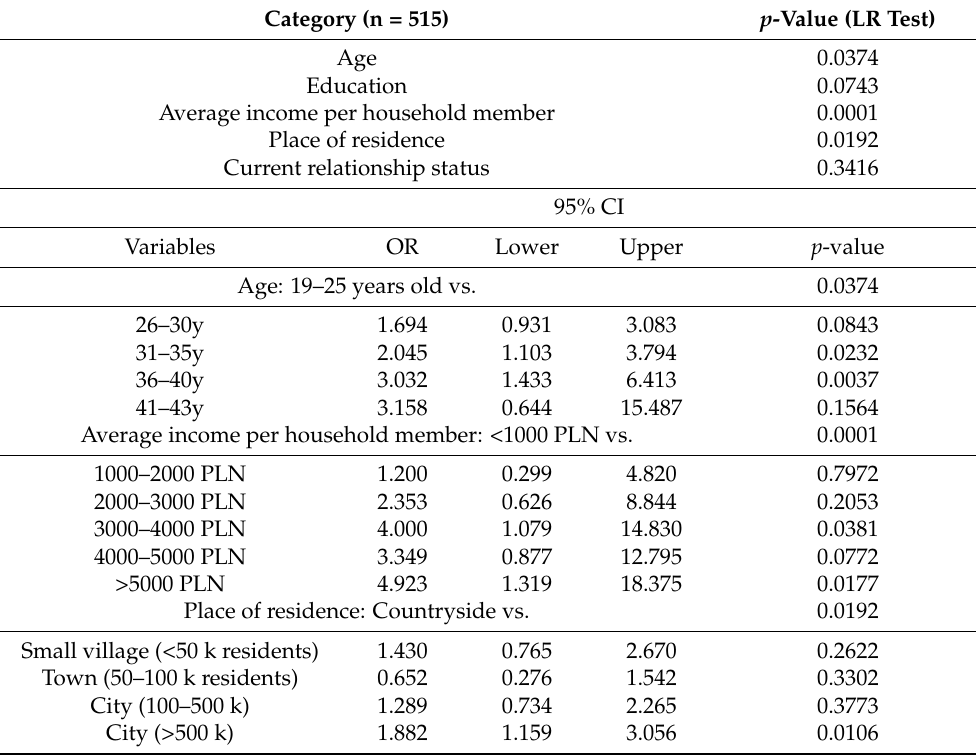
Table 3. Univariate regression analysis regarding influenza vaccination status.